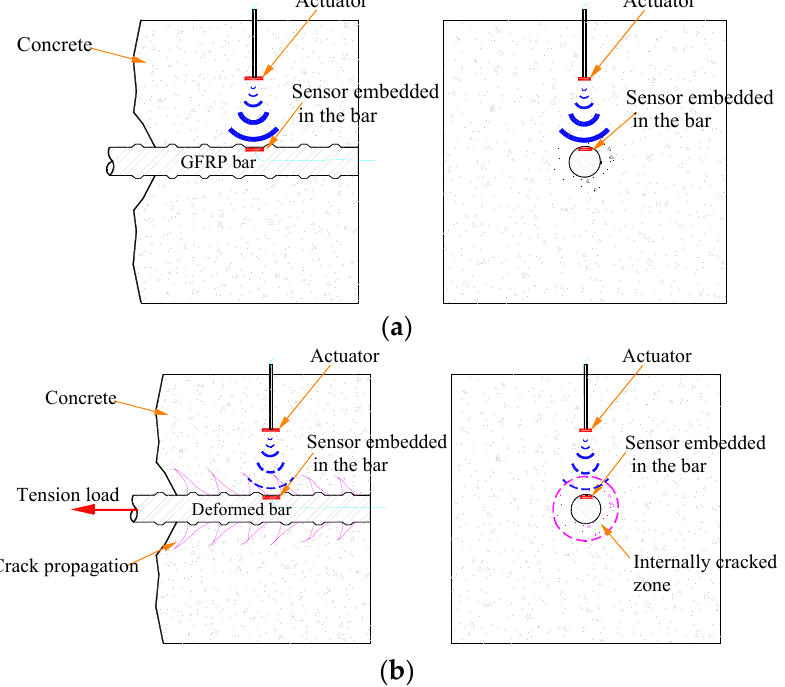
Figure 1. The principle of the active sensing approach detecting the debonding damage of GFRP bar–concrete structures: ( a ) health state (strong signal received by the SA sensors); ( b ) damaged state with debonding (weak signal received by the SA sensors).